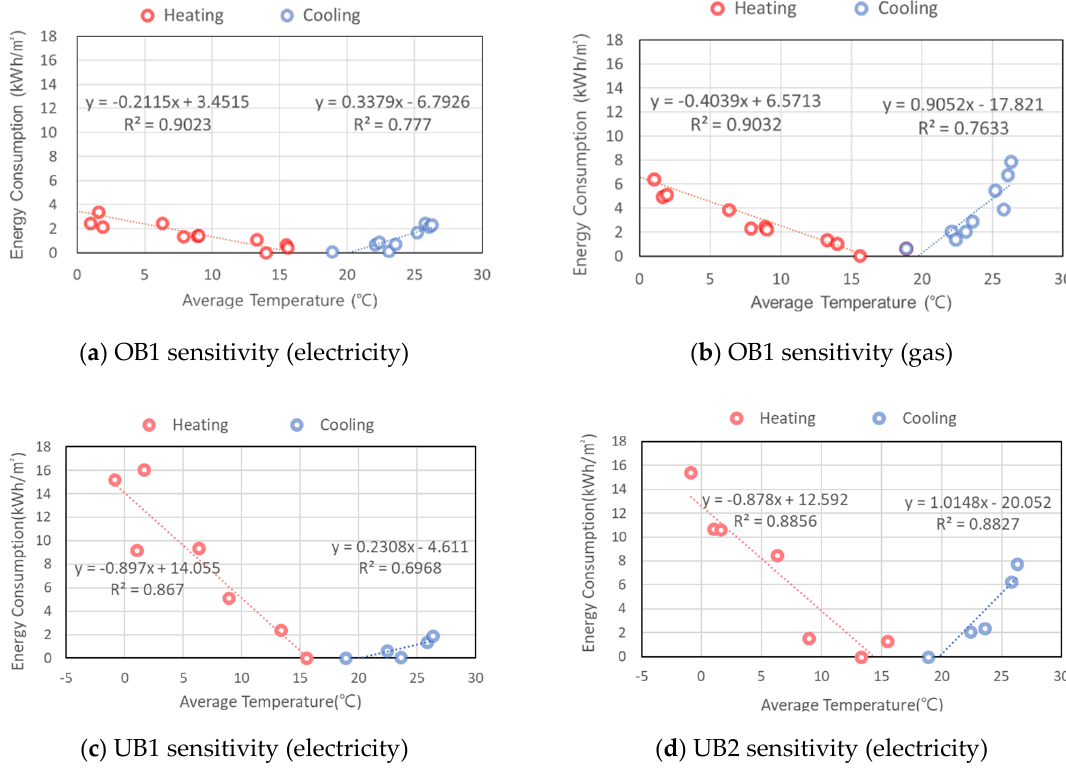
Figure 3. Heating and cooling sensitivity by Change Point Model: ( a ) OB1(electricity), ( b ) OB1(gas), ( c ) UB1(electricity), ( d ) UB2(electricity).